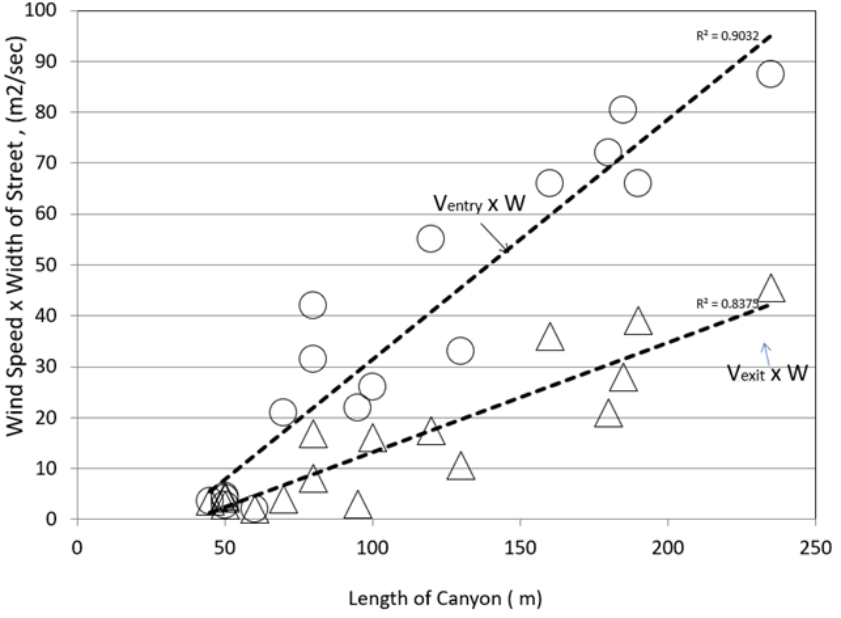
Figure 17. Entry and Exit Wind Speed in Canyons with Air Flow Parallel to their Axis.